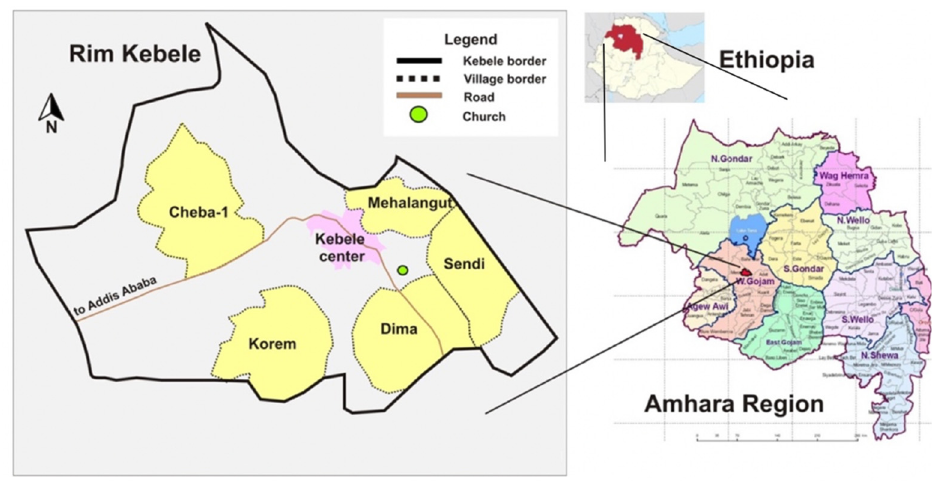
Figure 1. Location map of Rim Kebele in Ethiopia. Rim Kebele is in West Gojjam Zone of Amhara Region. This study was conducted in 5 sampled villages of Rim Kebele.